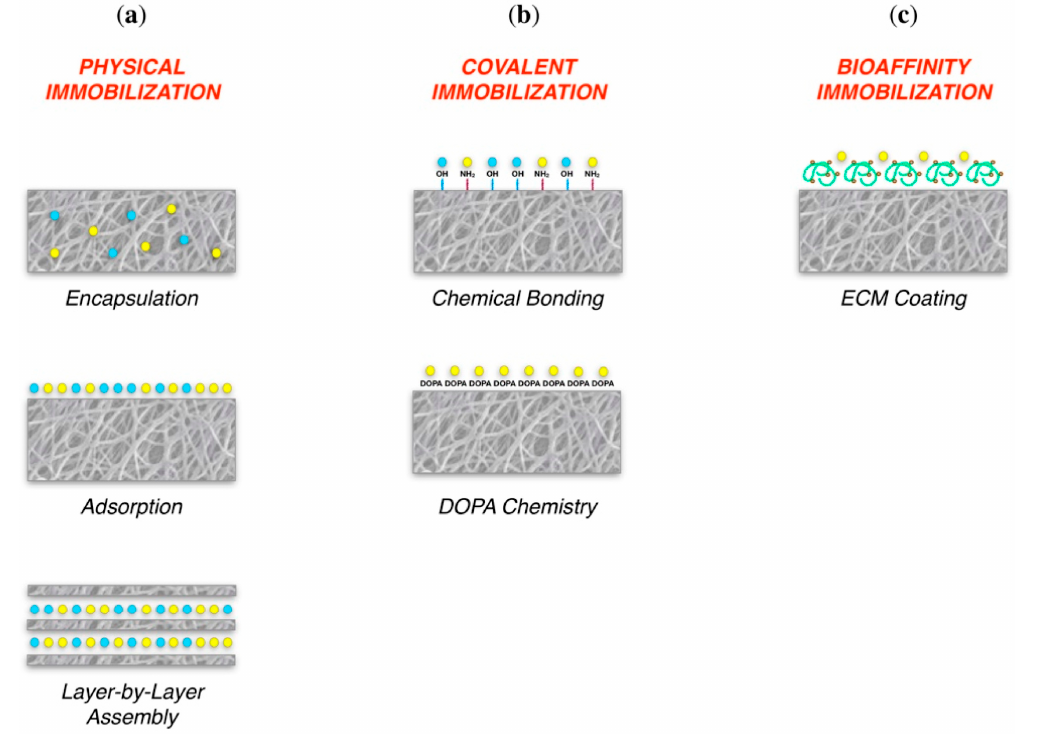
Figure 6. Graphical representation of functionalized scaffolds. ( a ) Physically immobilized bioactive molecules; ( b ) Cova- lently bound bioactive molecules; ( c ) Scaffold coated with ECM molecules. Reprinted from an open-access source [16].